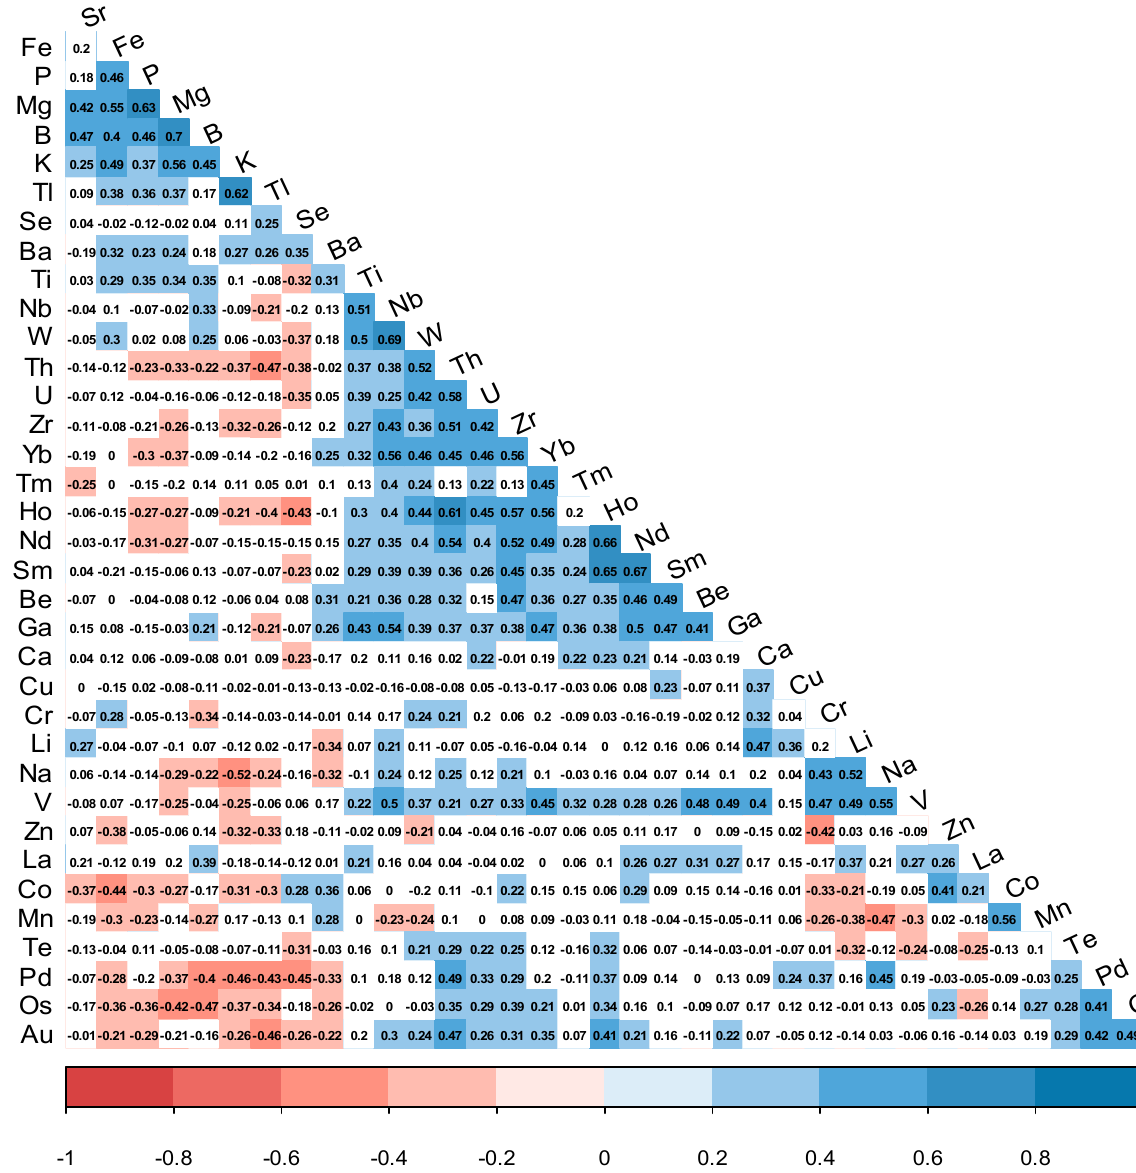
Figure 3. Correlation matrix plot for vintage year 2017, indicating the positive (with blue shading) and the negative (with red shading) correlation between metals.